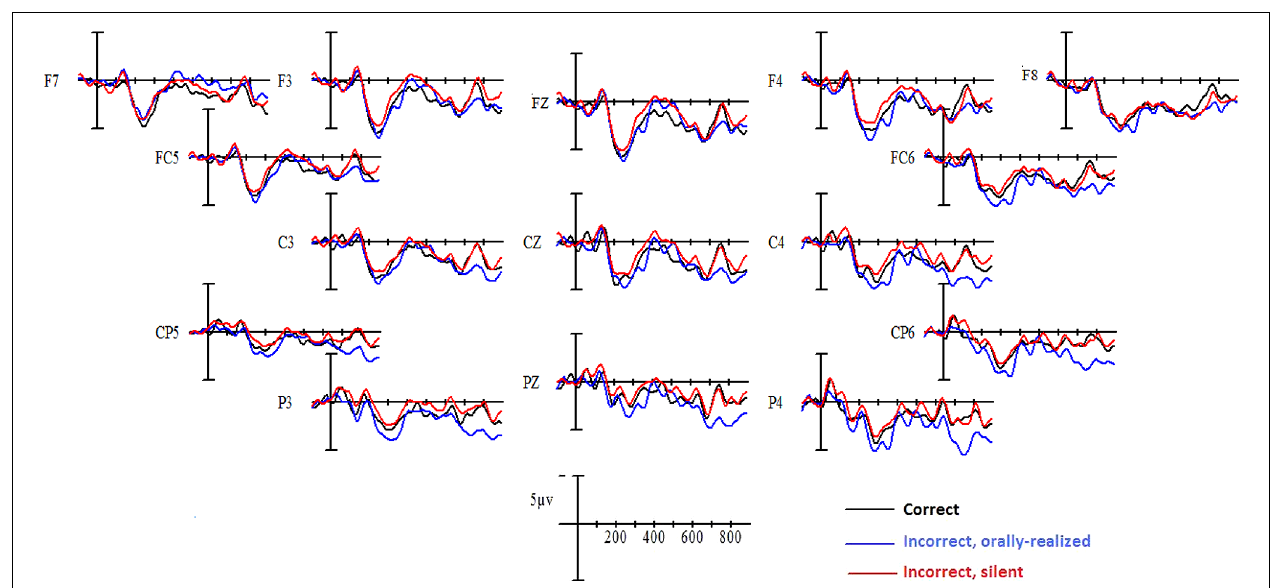
FIGURE 4 | Grand mean averages for Spanish L1–French L2 speakers as a function of verbal inflection condition and electrode site.